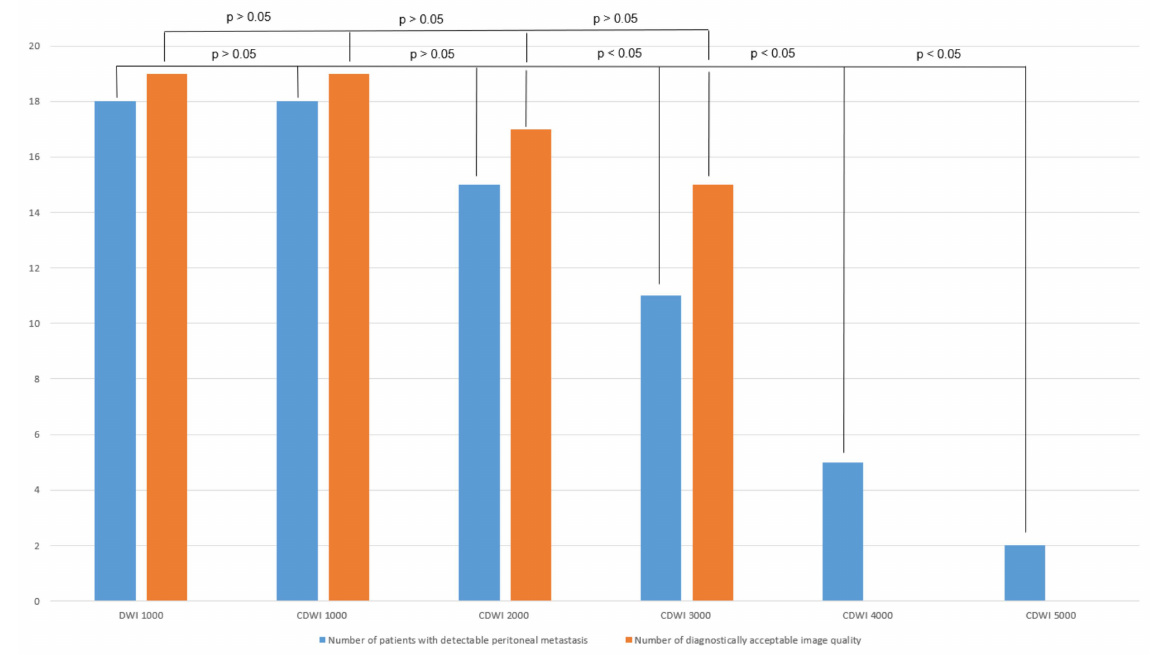
Figure 3. Bar graph showing the number of detected peritoneal carcinomatosis and acceptable image quality in DWI/c-DWI with b-values of 1000–5000 s/mm 2 . There were no significant differences between b = 1000 and b = 1000–2000 s/mm 2 in terms of detected lesions. There was a statistically significant decrease starting at b = 3000 s/mm 2 . Regarding image quality, no statistically significant differences were found between b = 1000 and b = 1000–3000 s/mm 2